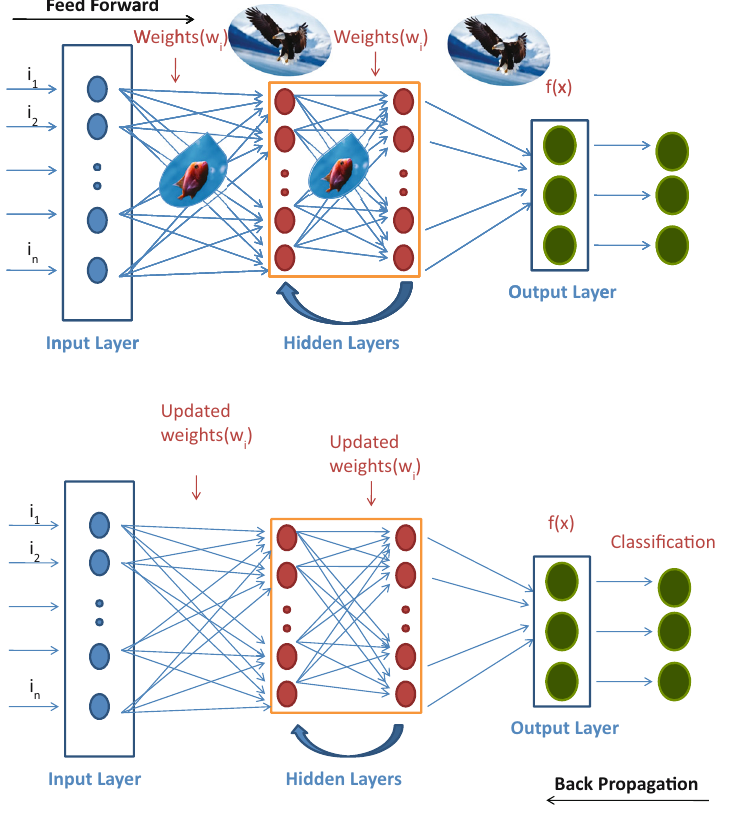
Figure 7: Proposed ARNN model for